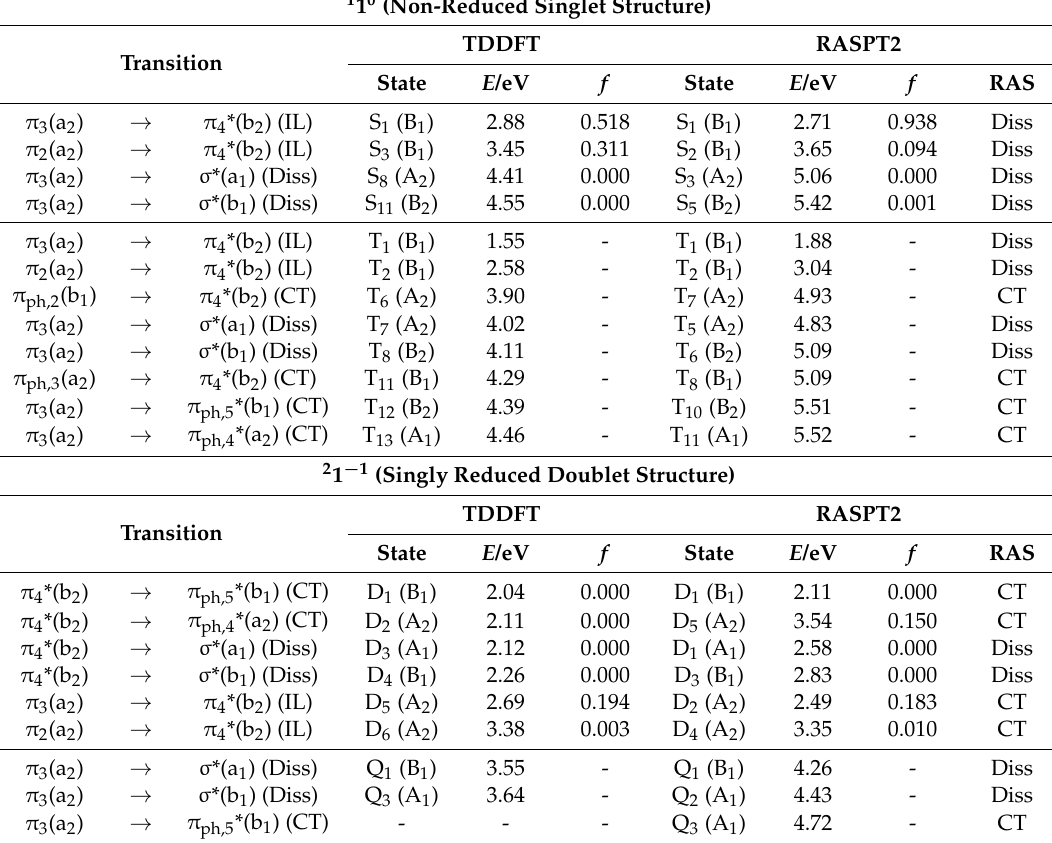
Table 1. Comparison of TDDFT and RASPT2 (RAS Diss and RAS CT ) results, namely the excitation energies, oscillator strengths, and excited state characters obtained in the C 2v -restricted GS structures 1 1 0 and 2 1 − 1 ,